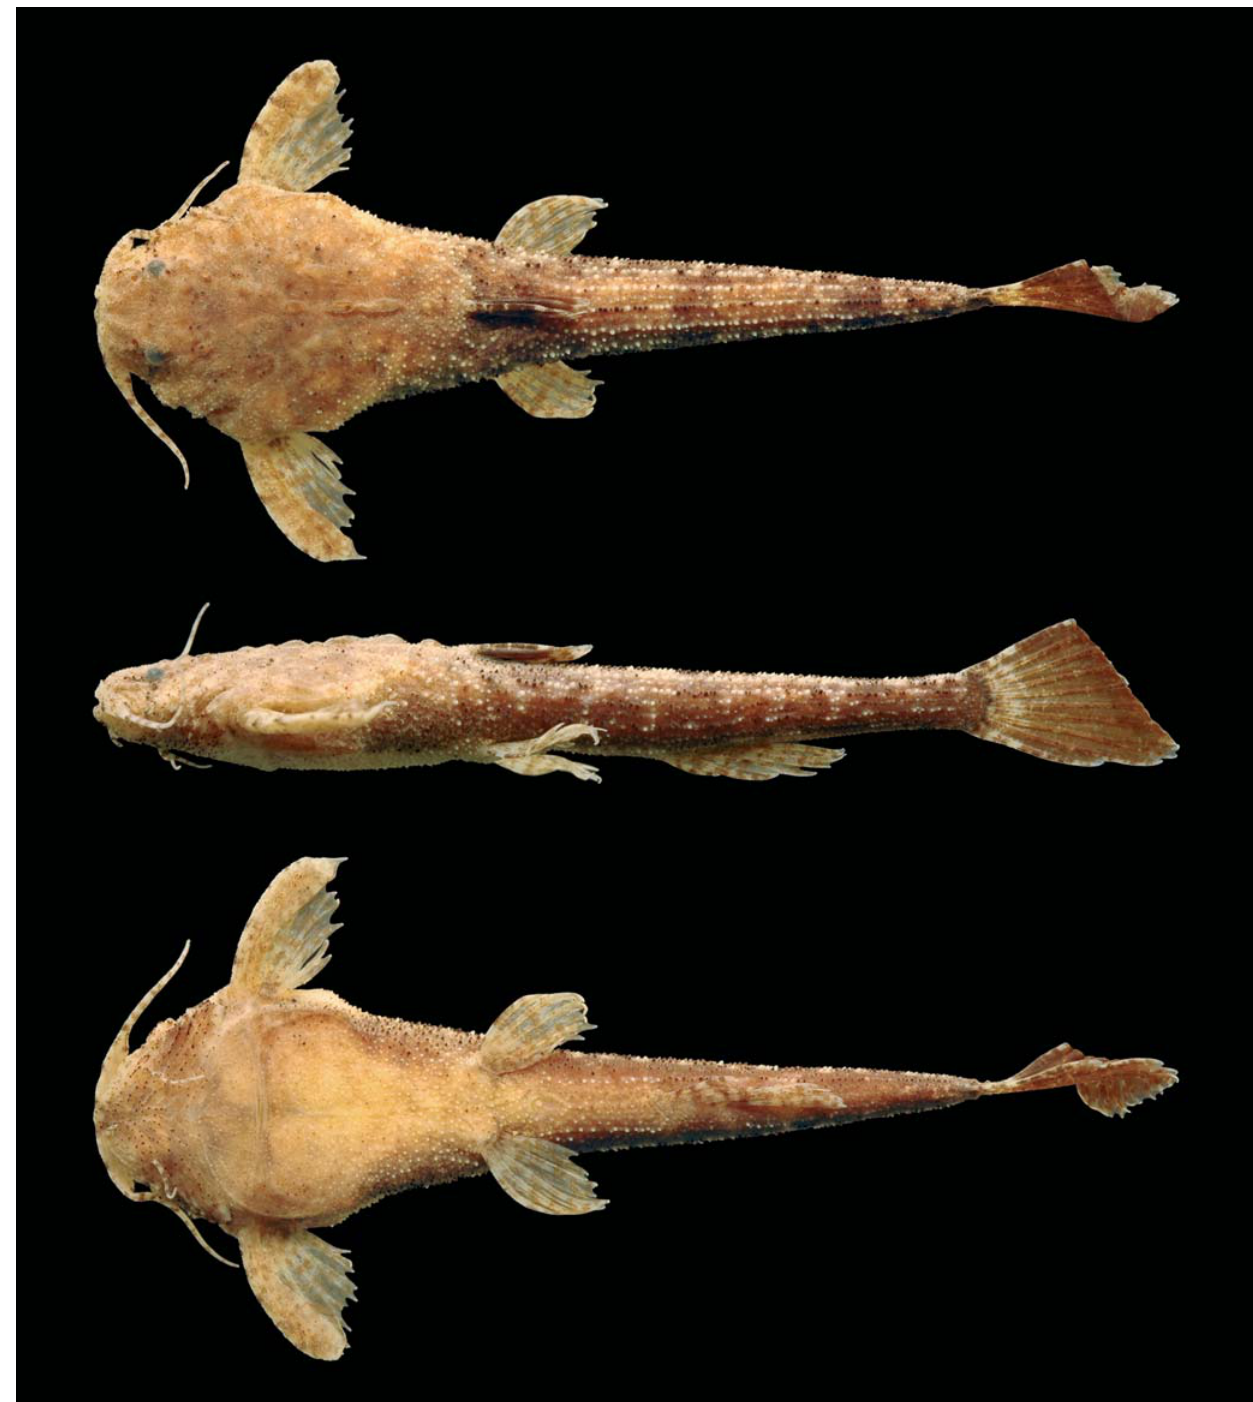
Fig. 4. Dorsal, lateral and ventral views of Pseudobunocephalus lundbergi , Holotype, ANSP 168817, 28.4 mm SL, Venezuela, Bolivar, caño Barranca, approximately 1.25 hours downstream from Jabillal (opposite bank) on río Caura (07°08’N 65°04’W), collected by J. Böhlke and W. Saul, 30 Jan 1977. Note the caudal fin is normal and intact, but has been creased and folded in preservation. Photographs by T. R.